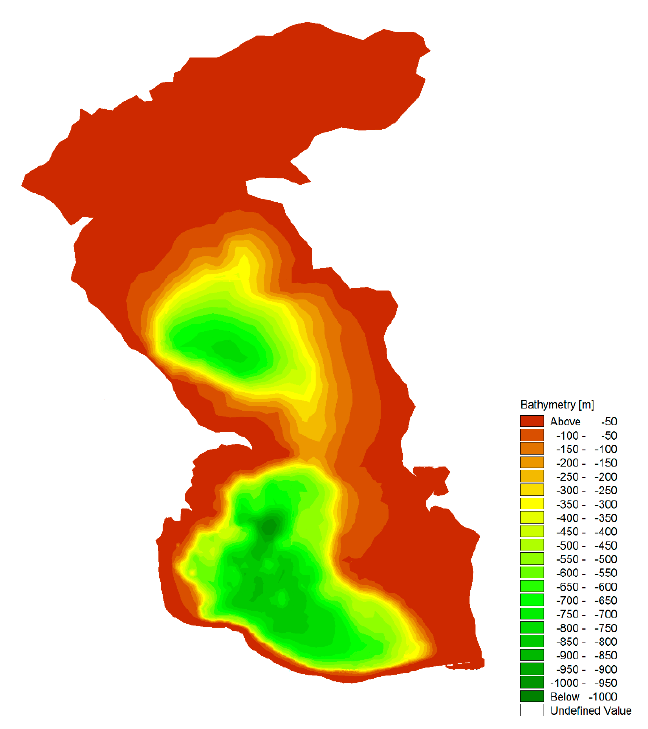
Figure 2. Bathymetric contour map of the Caspian Sea [26].